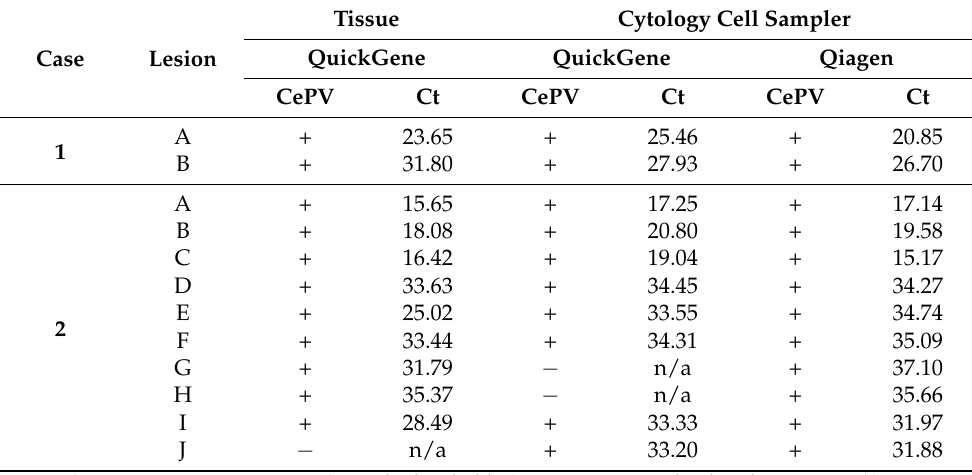
Table 1. Molecular results from tissue and cytology cell sampler sampling methods using both the DNA Tissue Kit S TM (QuickGene, Kurabo, Japan) and the DNeasy TM Blood and Tissue Kit (Qiagen, Inc., Valencia, CA, USA) on skin lesions from a bottlenose dolphin and an Atlantic spotted dolphin stranded on the Tenerife coasts, Canary Islands, Spain,